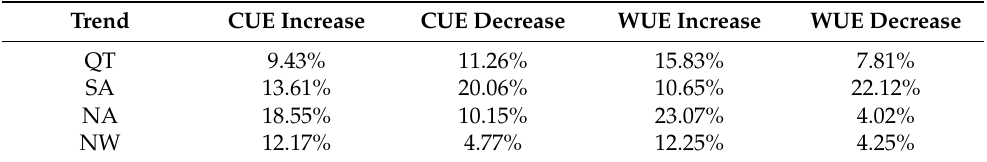
Table 1. CUE and WUE trends in different areas. Qinghai–Tibet Plateau: QT; South area: SA; North area: NA; Northwest area: